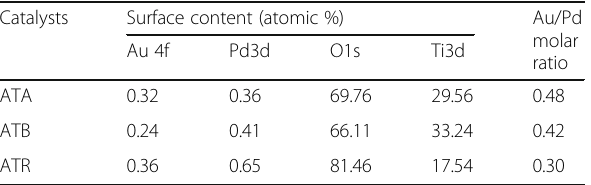
Table 2 Surface element composition on the Au-Pd/TiO 2 catalysts